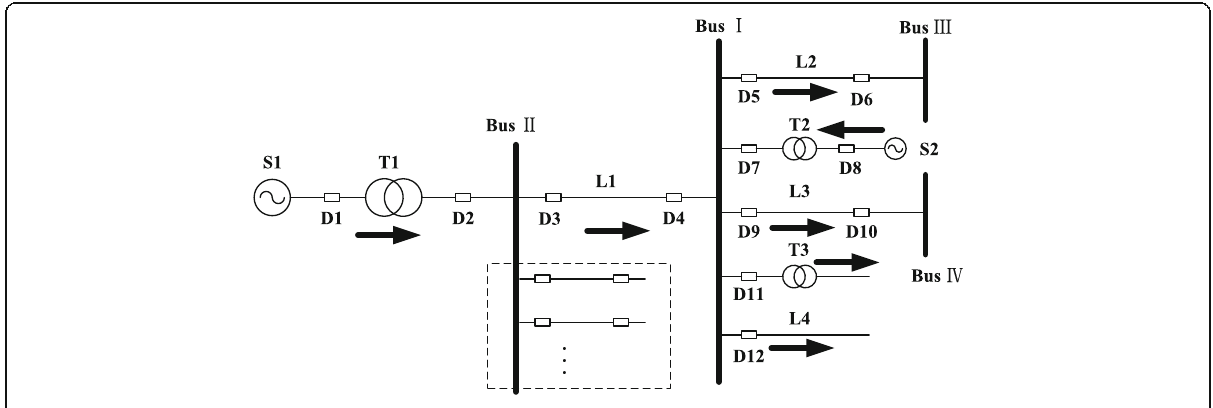
Fig. 1 Electric power network with micro-sources and the power flow